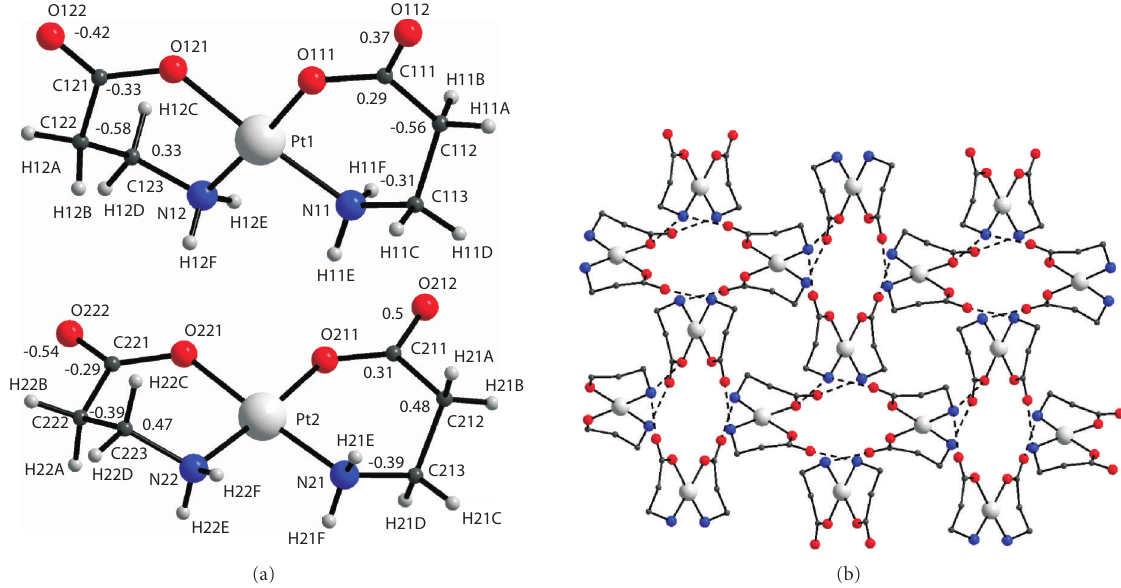
Figure 4: Molecular structure of Pt1 and Pt2 in cis -[Pt( β -Ala) 2 ] and deviations of atoms ( ˚A) from plane of the coordination square (a); structure of a layer